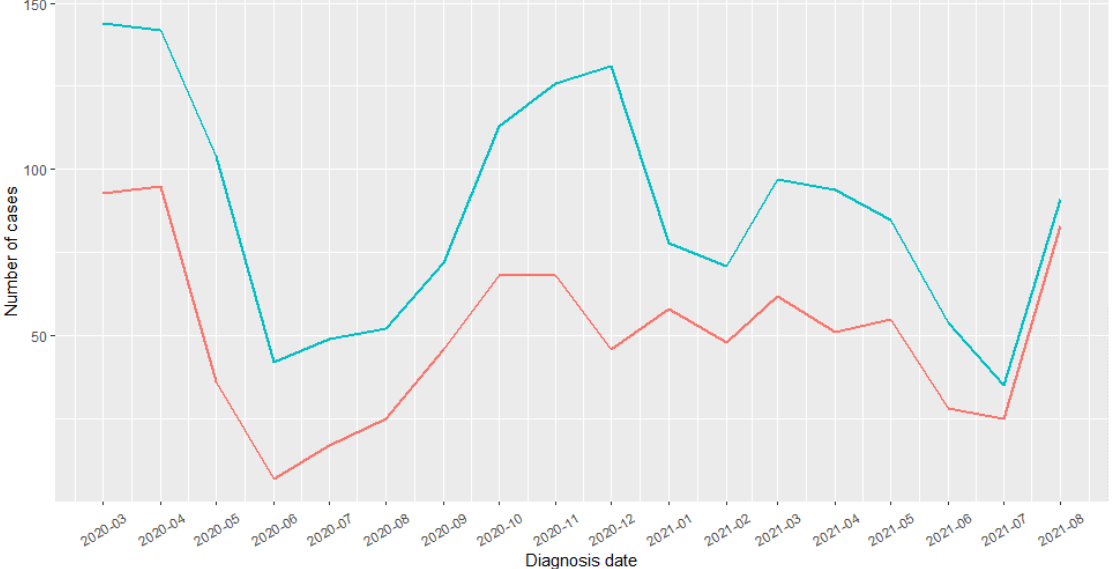
Figure 2. COVID-19 diagnoses distribution. Blue: children were hospitalized for COVID-19; Red: out of whom had been exposed to the MMR vaccine.